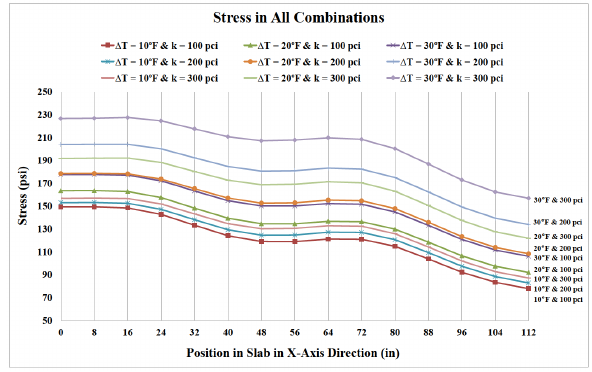
Figure 9: Stress for all combinations of curling temperature and k-Value Table 3: Comparisons of curling k & ∆ T 10 ∘ F 20 ∘